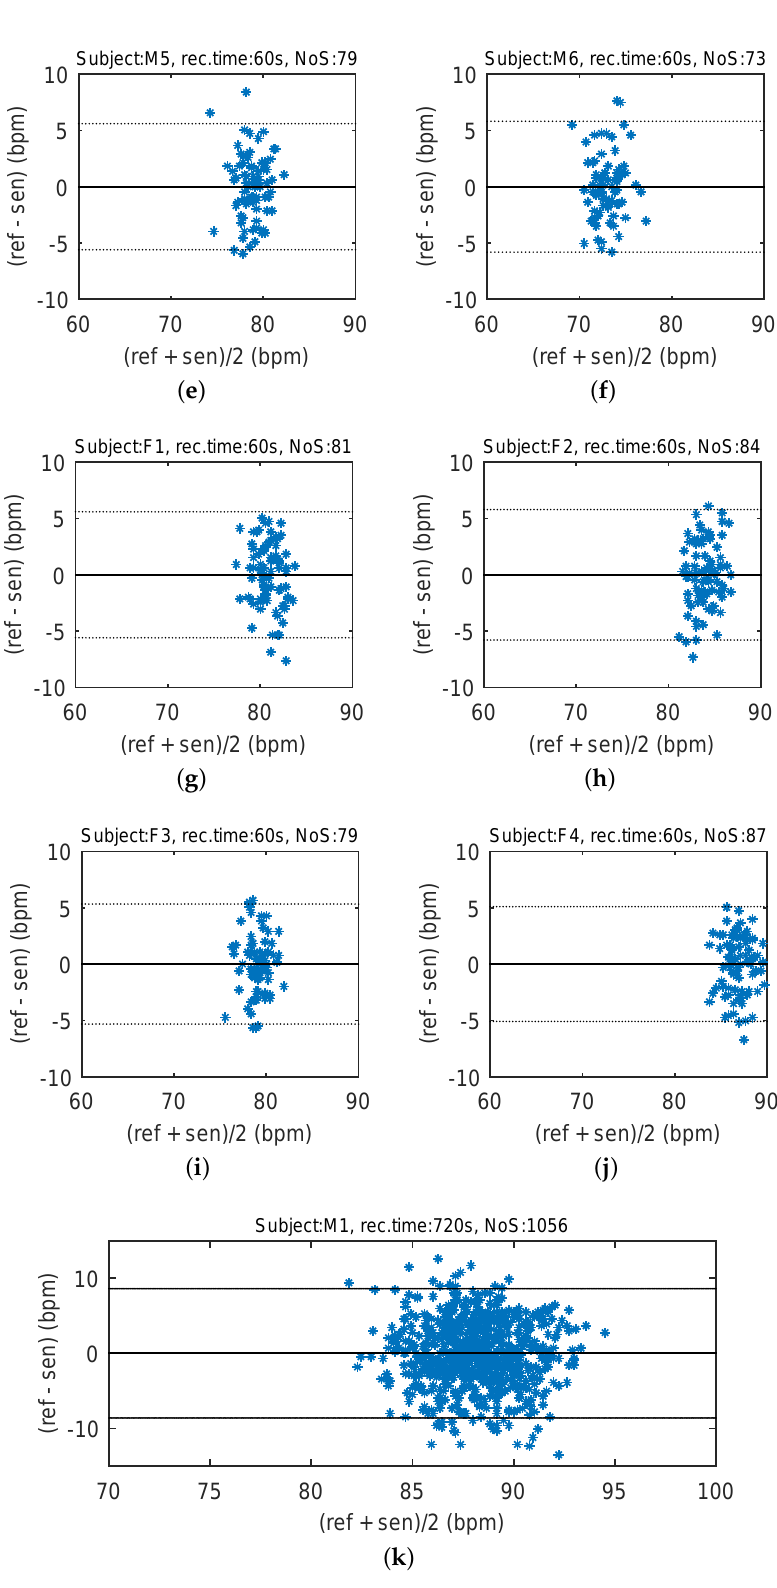
Figure 12. Reproducibility of HR determination capabilities of our novel sensor probe (based on comparison with ECG-based HR calculations) using the Bland-Altman method using data acquired from ten